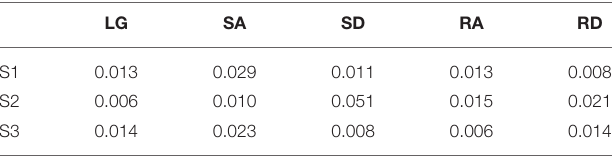
TABLE 1 | The repeatability of gait signals (waveforms) of subjects based on variance ratio analysis.